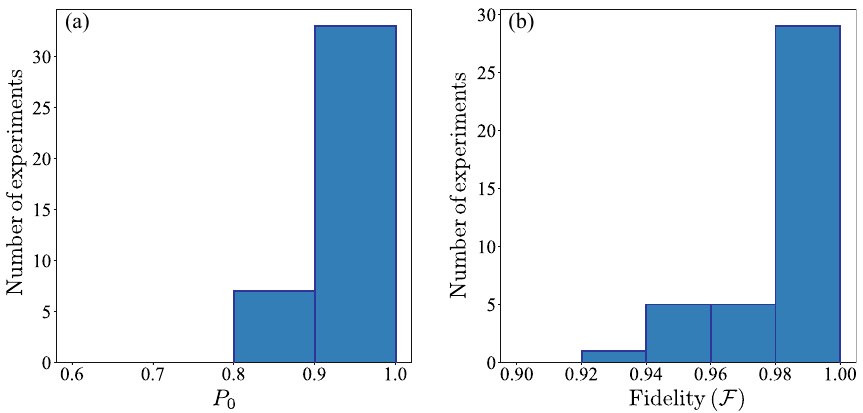
ˆ O = cos 1 σ x + sin 1 σ y , r = 0.9 10 10